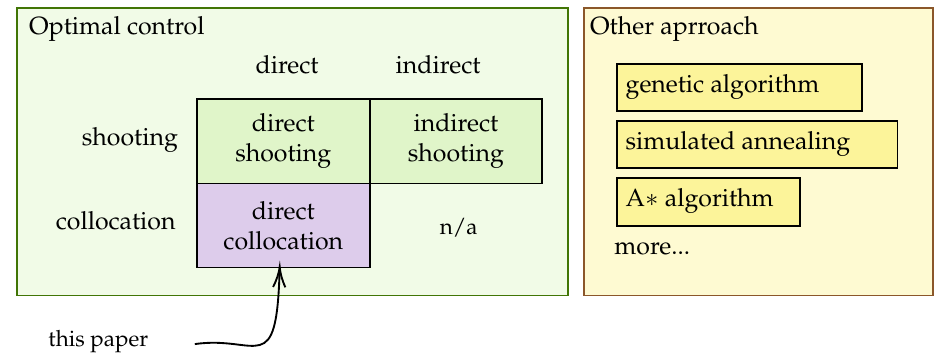
Figure 1. A simplified overview of trajectory optimization